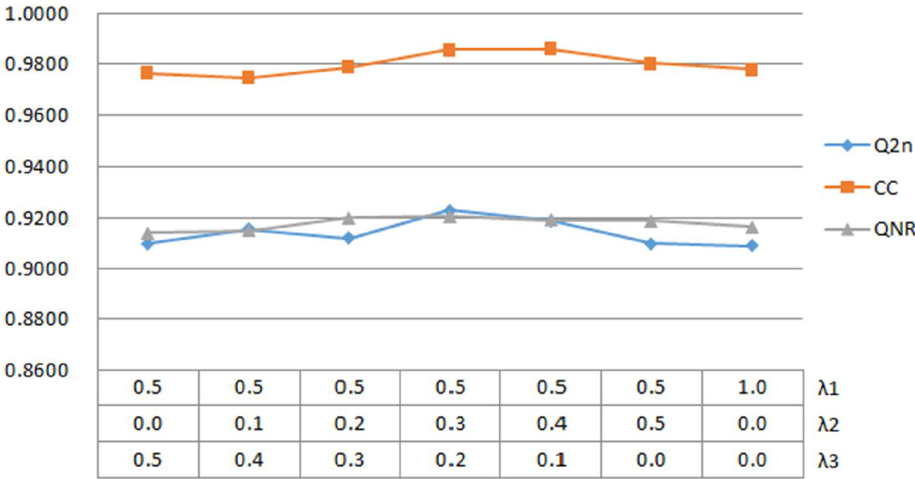
Figure 7. Line graph for mixed loss parameter validation.